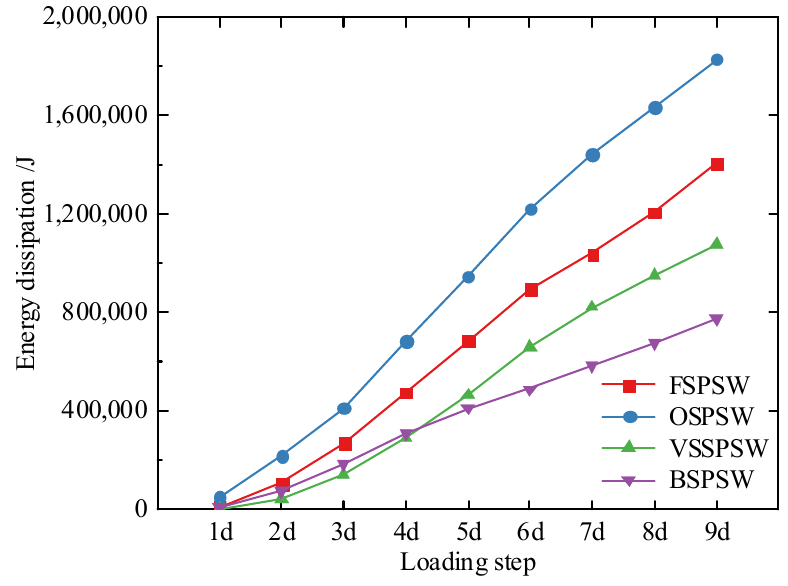
Figure 11. Energy dissipation of the FSPSW, OSPSW, VSSPSW, and BSPSW.